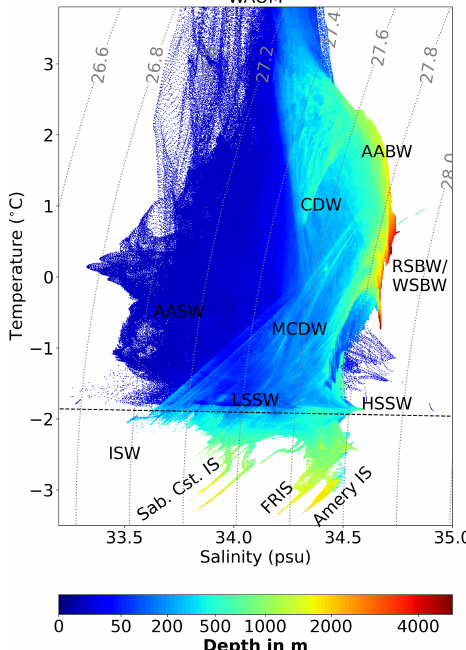
Figure D2. WAOM’s water masses. Shown are the 2007 mean potential temperature–salinity–depth distributions south of 65 ◦ S (off-shelf, on-shelf, and sub-ice-shelf cavities). For the analysis, each grid cell has been sorted into 1000 × 1000 temperature and salinity bins, and the depth shown for each bin is the volume-weighted average of all the grid cells in this bin. The dashed black lines show the freezing point at the surface, and the dotted grey lines are potential density anomaly contours (in kgm − 3 − 1000; referenced to the surface). Horizontal labels show different water masses: CDW indicates Circumpolar Deep Water, MCDW indicates Modified Circumpolar Deep Water, LSSW indicates low-salinity shelf water, HSSW indicates high-salinity shelf water, AASW indicates Antarctic Surface Water, ISW indicates Ice Shelf Water, AABW indicates Antarctic Bottom Water, and WSBW/RSBW indicates Weddell/Ross Sea Bottom Water. Rotated labels show source region. Abbreviations are ice shelf (IS), Filchner–Ronne (FR), and Sabrina Coast (Sab. Cst.).